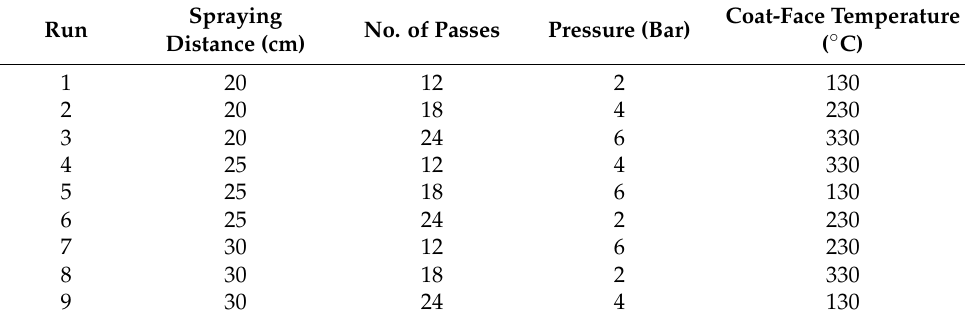
Table 2. Experimental data for the coating process.